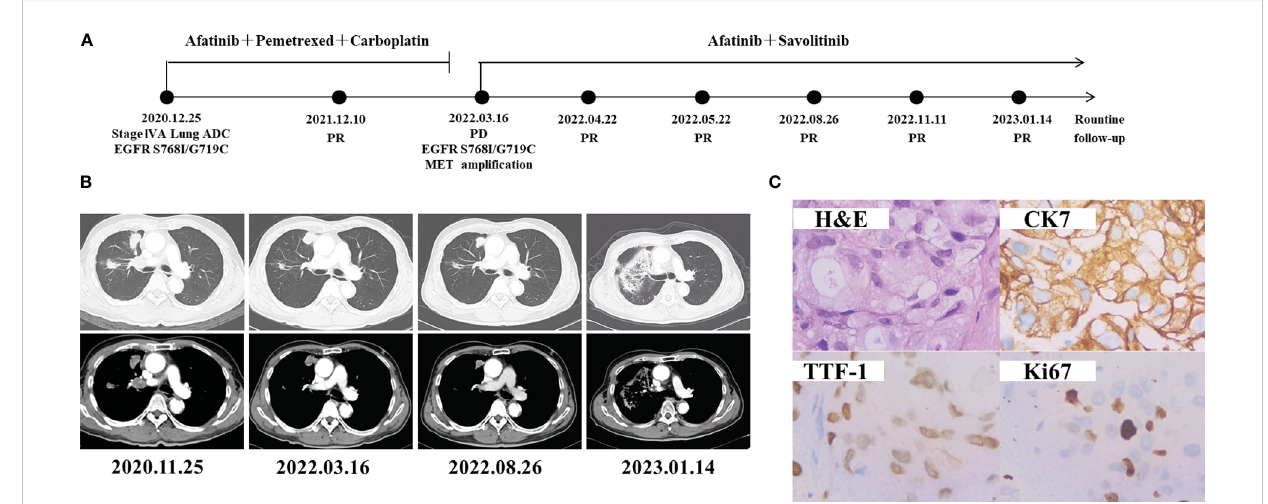
FIGURE 1 Schematic of treatment history of Case 1. (A) The timeline of treatment. (B) Chest CT images throughout the disease course. (C) Pathological examination of the surgical specimen. IHC testing (400×) results showed positive expression of TTF-1, CK7 and